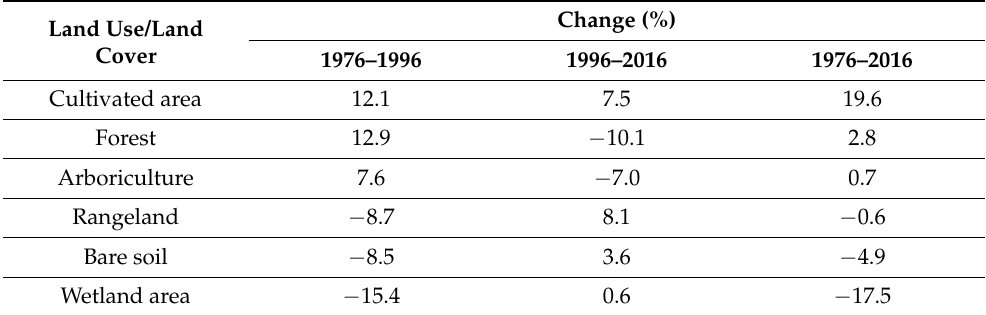
Table 5. Percentage change between 1976, 1996, and 2016 for the land use/land cover classification.